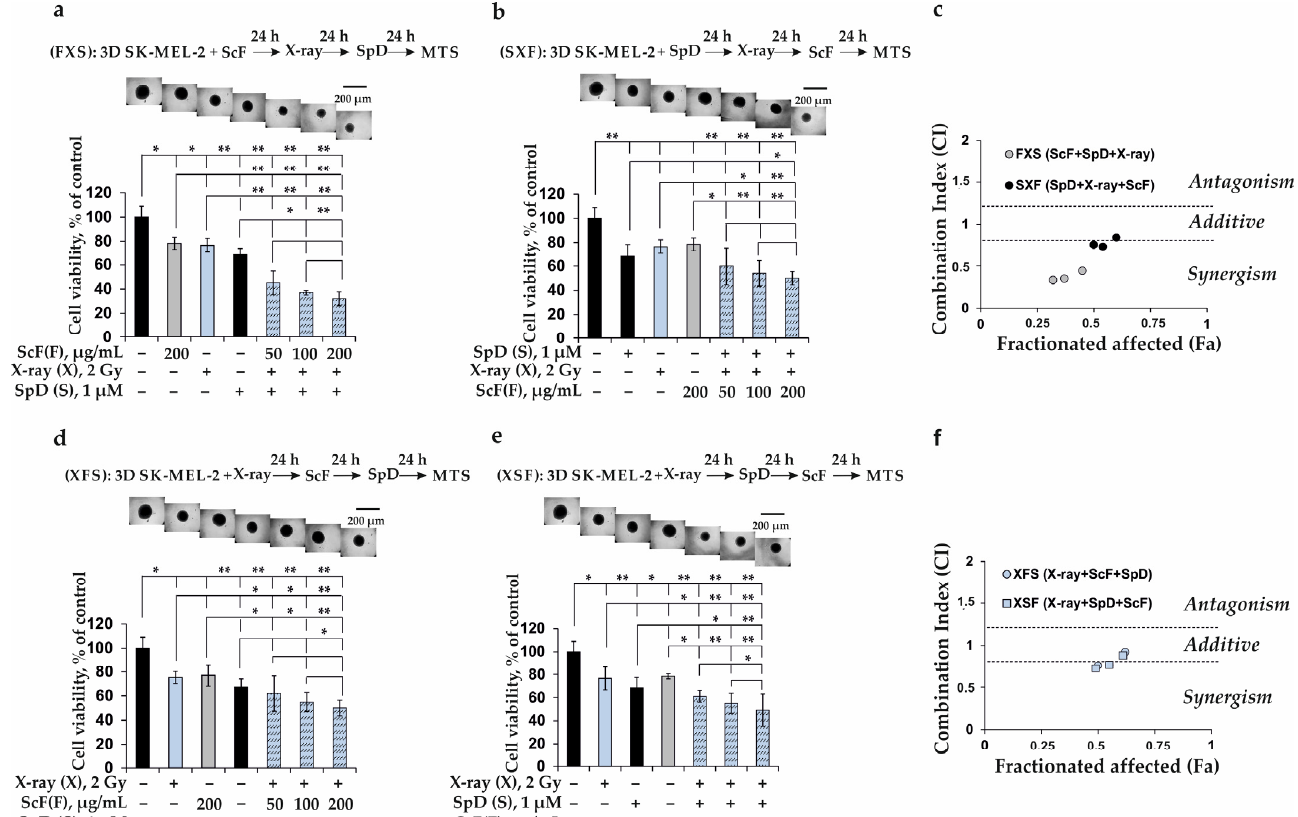
Figure 5. Three-component combined effect of fucoidan from S. cichorioides (ScF) with pacificusoside D from S. pacificus (SpD) and X-ray on the viability of 3D human melanoma cells SK-MEL-2. SK-MEL-2 spheroids were treated by ( a ) ScF (50, 100, and 200 µg/mL) in combination with X-ray (2 Gy) and SpD (1 µM) (FXS combination); ( b ) SpD (1 µM) in combination with X-ray (2 Gy) and ScF (50, 100, and 200 µg/mL) (SXF combination); ( d ) X-ray (2 Gy) in combination with ScF (50, 100, and 200 µg/mL) and SpD (1 µM) (XFS combination) ( e ) X-ray (2 Gy) in combination with SpD (1 µM) and ScF (50, 100, and 200 µg/mL) (XSF combination) for total 72 h. The cell viability was estimated using the MTS assay. The cell viability was estimated using the MTS assay. Photographs ( n = 6, where n = number of photographs) of each spheroid were taken using the ZOE™ Fluorescent Cell Imager. Data show the mean of three independent experiments ± SD. A one-way ANOVA and Tukey’s HSD test for multiple comparisons indicated the statistical significance (* p < 0.05 and ** p < 0.01). ( c , f ) Type of combined action of FXS, SXF, XFS, and XSF combinations calculated using Compusyn 1.0.1 software (ComboSyn, Inc., USA).